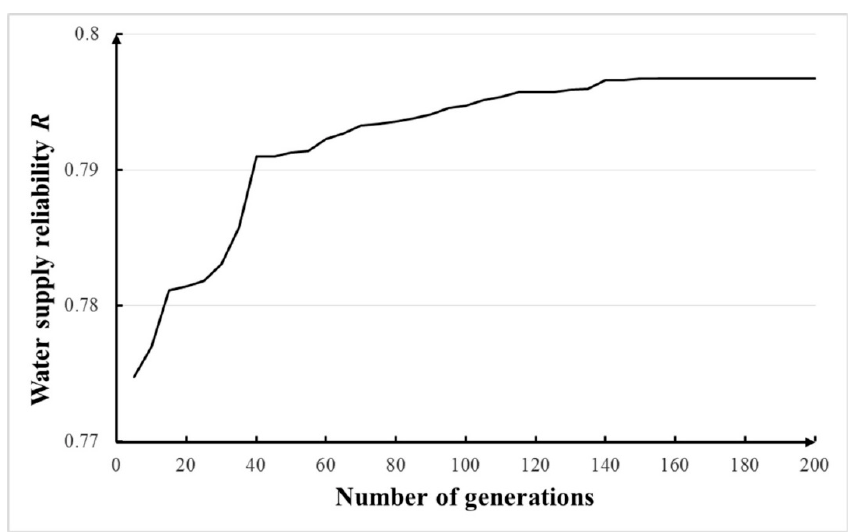
Figure 6. Sensitivity of number of generations in Monte Carlo GA.